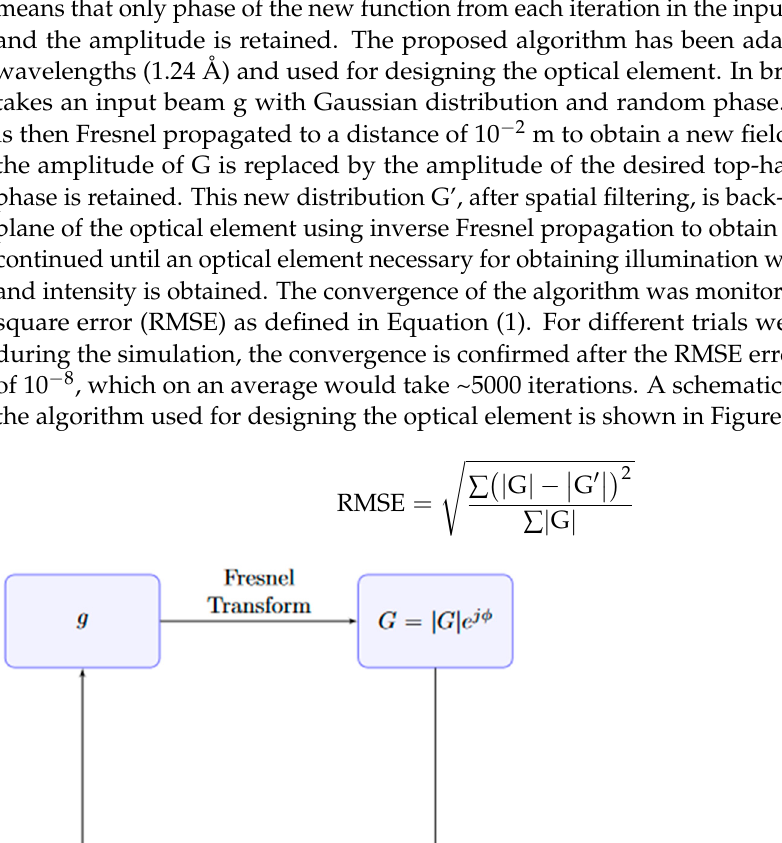
Table 1. Summary of parameters used for